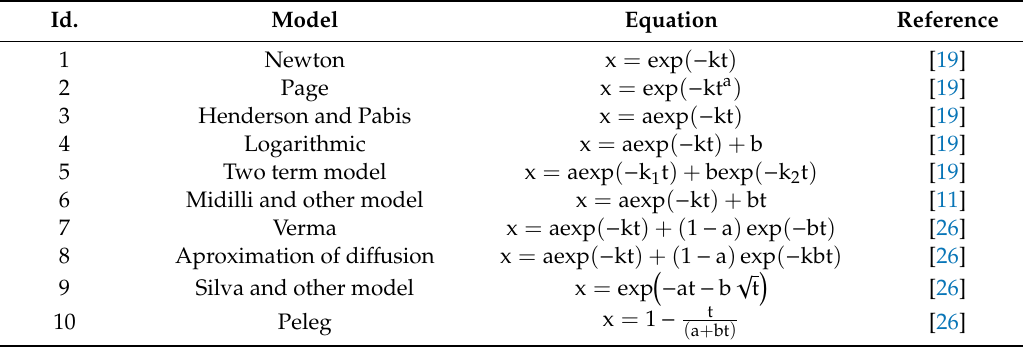
Table 1. Mathematical model applied to the experimental data of moisture during the cocoa bean roasting process.